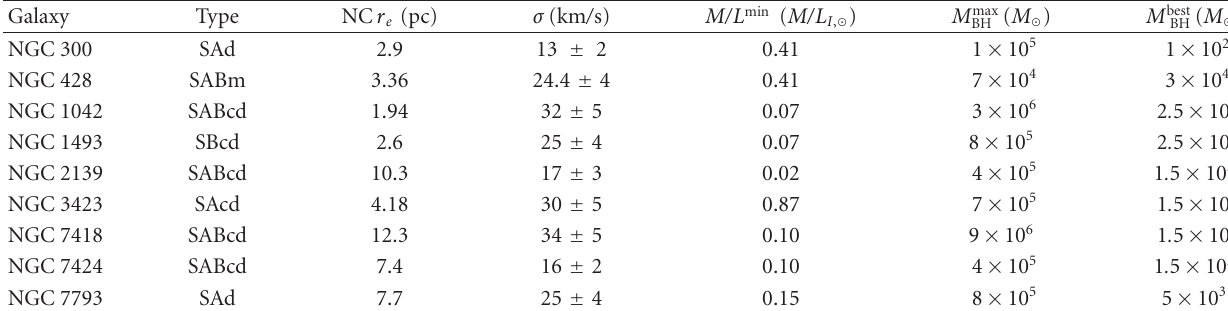
Table 1: Properties of the sample of NCs in bulgeless